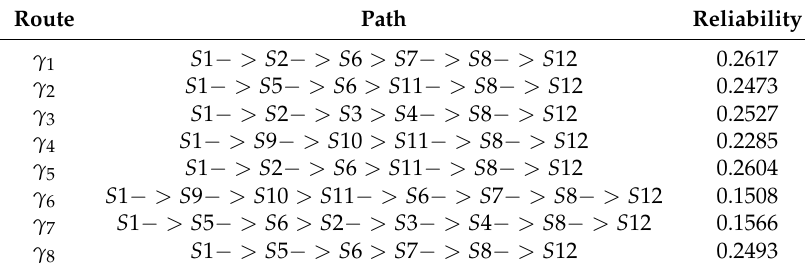
Figure 4. Possible routing path in IoT-SDN and node status. Table 2. Routing path reliability.